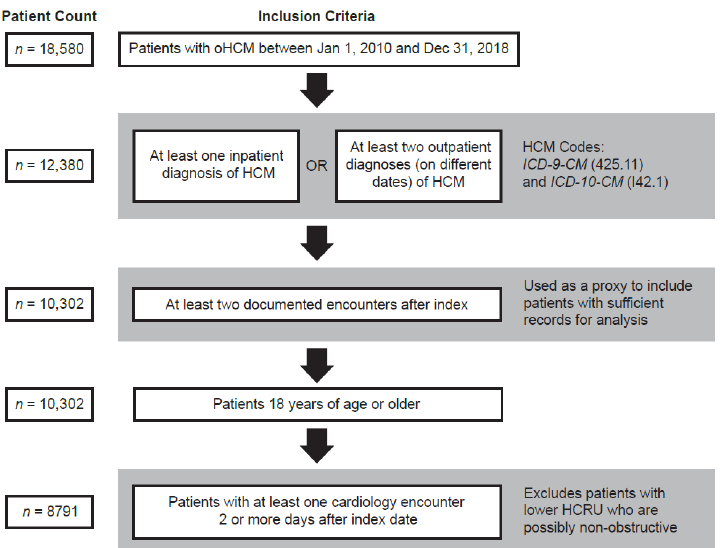
Figure 1. Flow chart of oHCM cohort attrition. HCM: hypertrophic cardiomyopathy; HCRU: healthcare resource utilization; ICD-9-CM: International Classification of Disease, Ninth Revision, Clinical Modification; ICD-10-CM: International Classification of Disease, Tenth Revision, Clinical Modification; and oHCM: obstructive hypertrophic cardiomyopathy.